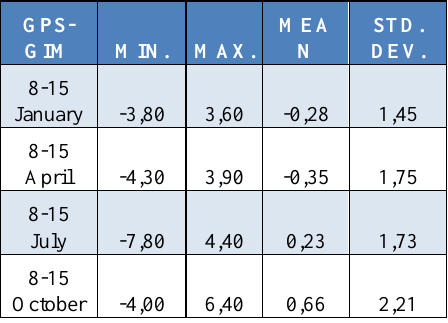
Table 2. Comparison of GPS-GIM TEC Values